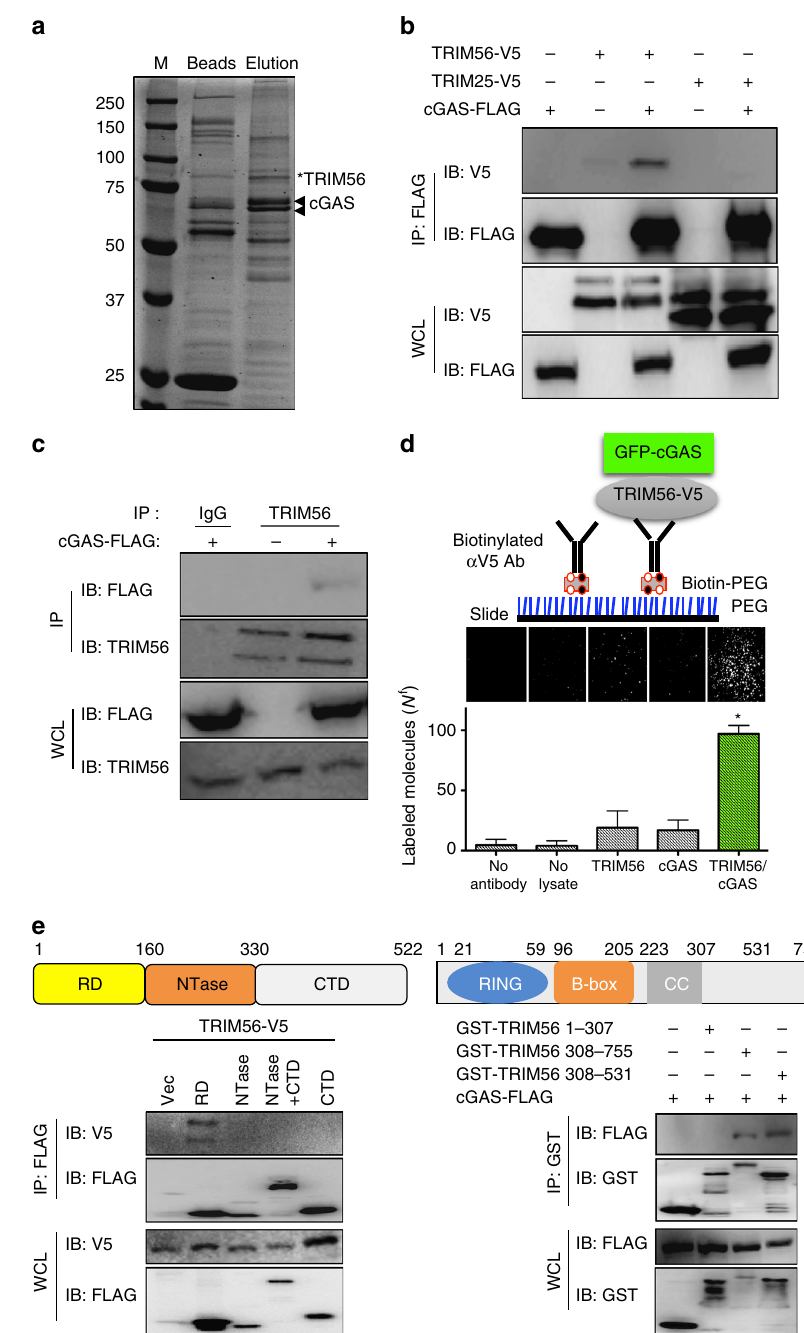
Fig. 1 TRIM56 interacts with cGAS. a HEK293T cells were transiently transfected with cGAS-FLAG and protein complexes were puri fi ed from cell lysates with anti-FLAG M2 beads. The immunoprecipitates were eluted with FLAG peptides and fractionated using SDS-PAGE followed by Coommassie blue staining. The bands for TRIM56 and cGAS identi fi ed by mass spectrometry are indicated on the right. b Co-immunoprecipitation analysis of the interaction between cGAS-FLAG and TRIM56-V5. HEK293T cells expressing cGAS-FLAG were co-transfected with TRIM56-V5 or TRIM25-V5. cGAS-FLAG immunoprecipitates were probed with FLAG and V5 antibody and whole-cell lysates (WCLs) were probed with FLAG and V5 antibody, as indicated. c cGAS interacts with endogenously expressed TRIM56. HEK293T cells were transfected with cGAS-FLAG. Rabbit IgG or TRIM56 immunoprecipitates were probed with FLAG antibody, and WCLs were probed with TRIM56 and FLAG, as indicated. d cGAS-FLAG was transiently coexpressed with TRIM56-V5 in HEK293T cells. TRIM56-V5 was pulled down for SiMPull analysis. Top panel: schematic depiction of cGAS SiMPull; middle panel: representative GFP fl uorescence images; bottom panel: average number of molecules per imaging area ( N f ). e The N-terminal regulatory domain of cGAS interacts with the C- terminal NHL homologous region of TRIM56. Left panel: the regulatory domain of cGAS binds to TRIM56. WCLs of HEK293T cells transfected with TRIM56-V5 and cGAS truncation mutants were used for immunoprecipitation and immunoblotting with the indicated antibodies. Right panel: the C- terminus domain (308 – 531) of TRIM56 interacts with cGAS. WCLs of HEK293T cells transfected with cGAS-FLAG and TRIM56 truncation mutants were used for immunoprecipitation and immunoblotting with the indicated antibodies. Data are representative of two independent experiments a – e . Error bars indicate mean ± s.d. of n = 3. * P < 0.05 versus control using Student ’ s t -test ( d ). Full blots are shown in Supplementary Fig.